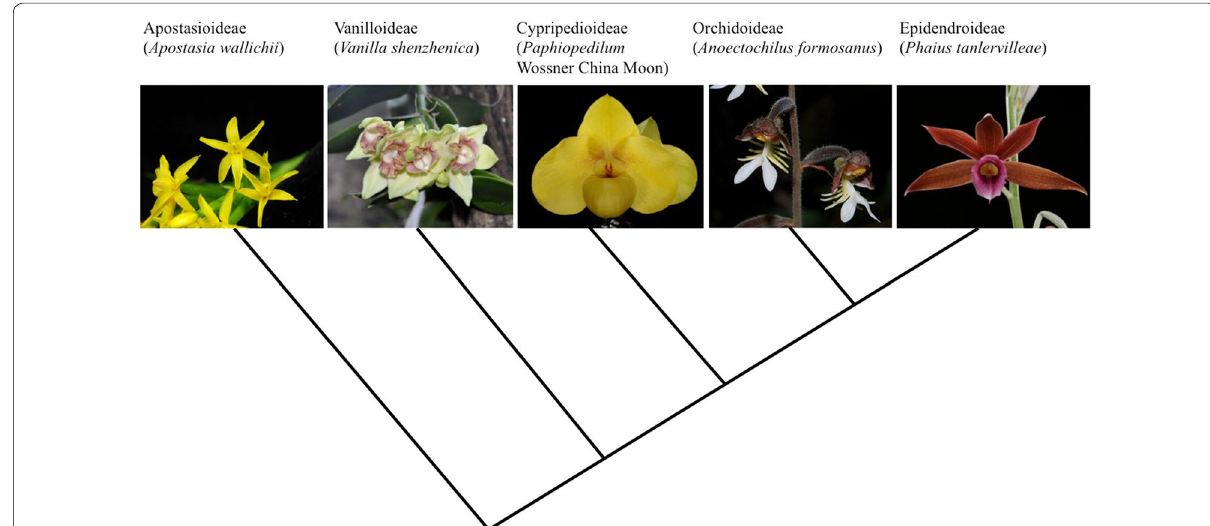
Fig. 1 The phylogenetic relationship among five subfamilies of Orchidaceae, and their example